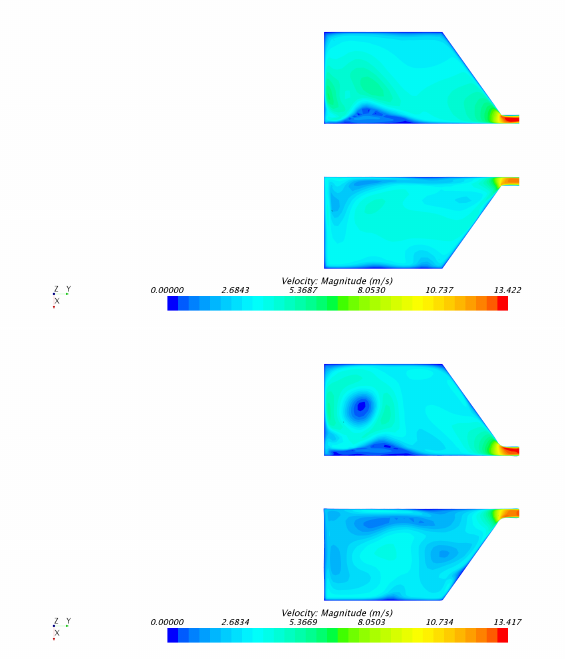
Fig. 5. Nozzle original (upper) and optimized shape - velocity flow field